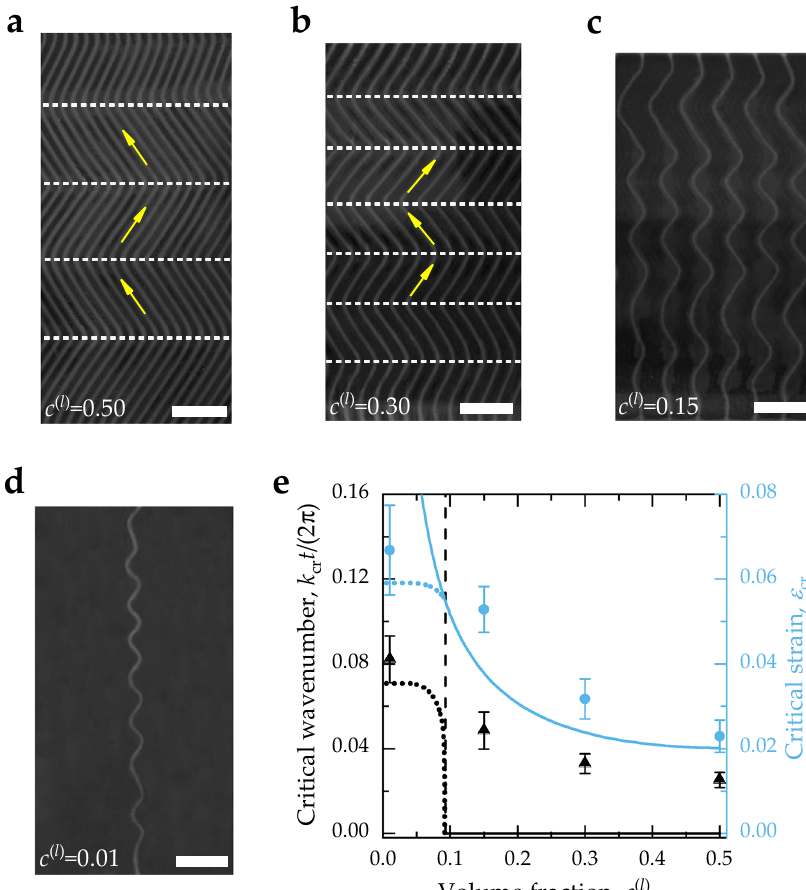
Fig. 2 Experimental observations of the transition from domain to wavy modes. a c ð l Þ ¼ 0 : 50 , b c ð l Þ ¼ 0 : 30 , c c ð l Þ ¼ 0 : 15 , d c ð l Þ ¼ 0 : 01 . The deformed con fi gurations are given at ε = 0.16 ( a ), 0.19 ( b ), and 0.22 ( c , d ). Scale bar: 10 mm. e Numerical prediction of critical strain and critical wavenumber vs. stiffer layer volume fraction in soft laminates. The dashed vertical line denotes the transition value of the volume fraction between long-wave and microscopic instability. Blue circular and black triangular points refer to the experimental critical strains and wavenumbers, respectively. The dotted and continuous curves are numerical results for microscopic and long-wave instabilities, respectively. Error bars indicate standard deviations.